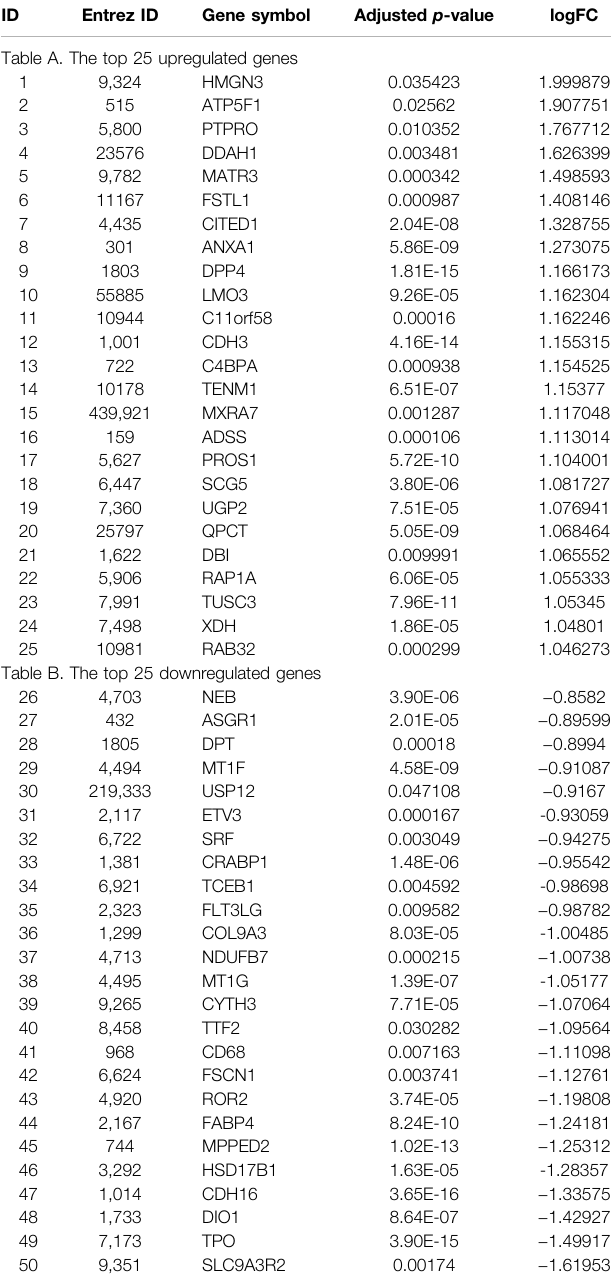
TABLE 2| Top25up- and downregulated DEGsidenti fi ed byStudent ’ s t test and fold change method (logFC > 0.58 or logFC < -0.58 and adjusted p -value < 0.05) combining all fi ve datasets in Table 1 .